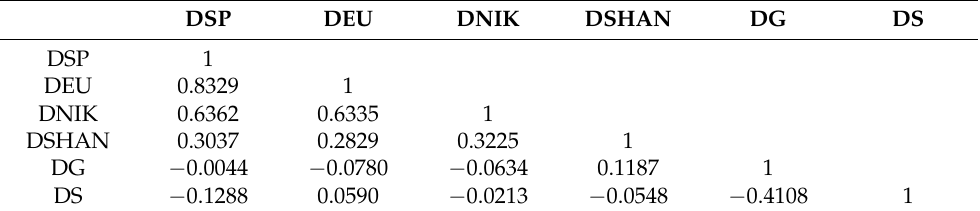
Table 2. Correlation Matrix of Asset Returns. Monthly Data: 1999M2-2019M3 (242